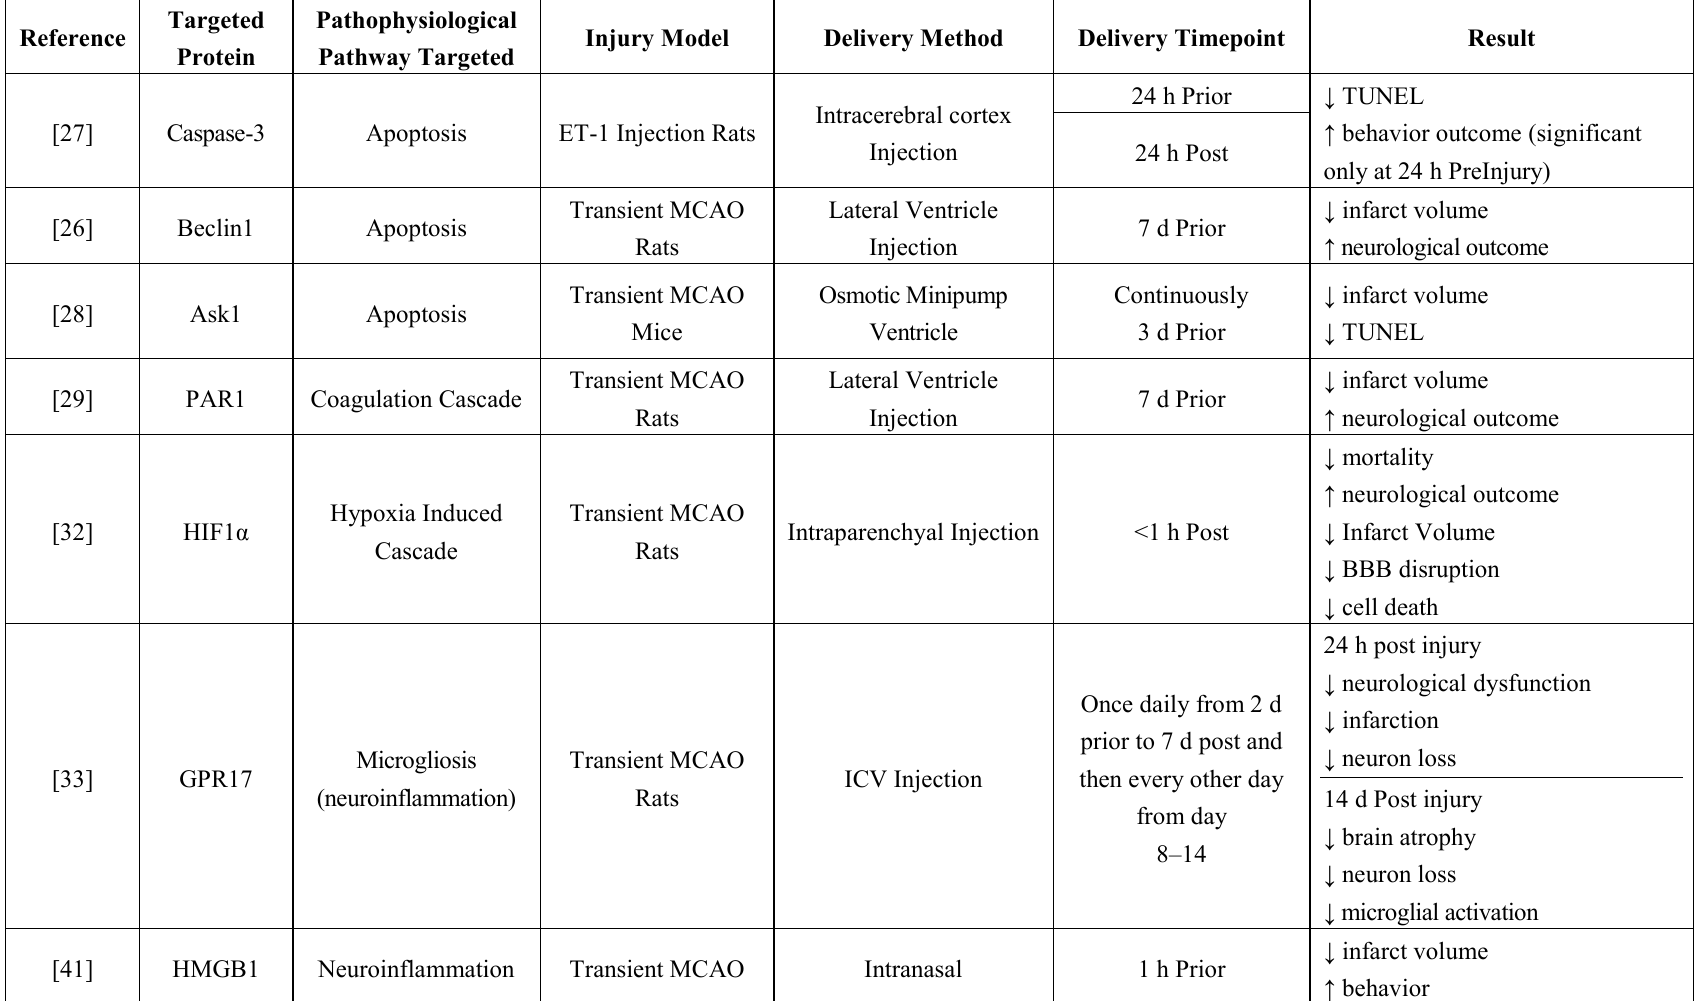
Table 2. Published in vivo usage of RNA interference as a therapeutic tool in Ischemic Stroke